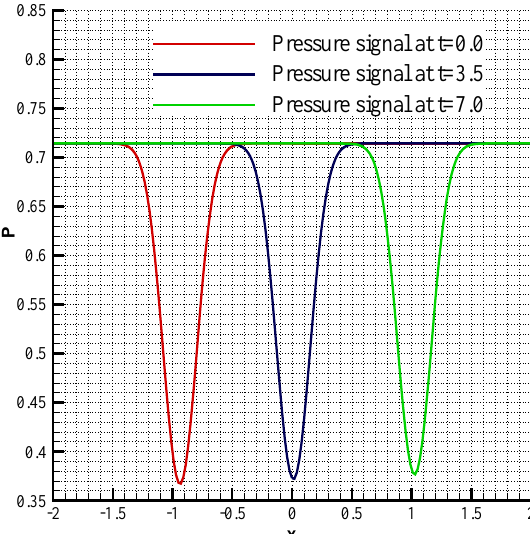
Figure 10. Computed pressure signals at three different times (corresponding to Figure 9a–c) for a convected